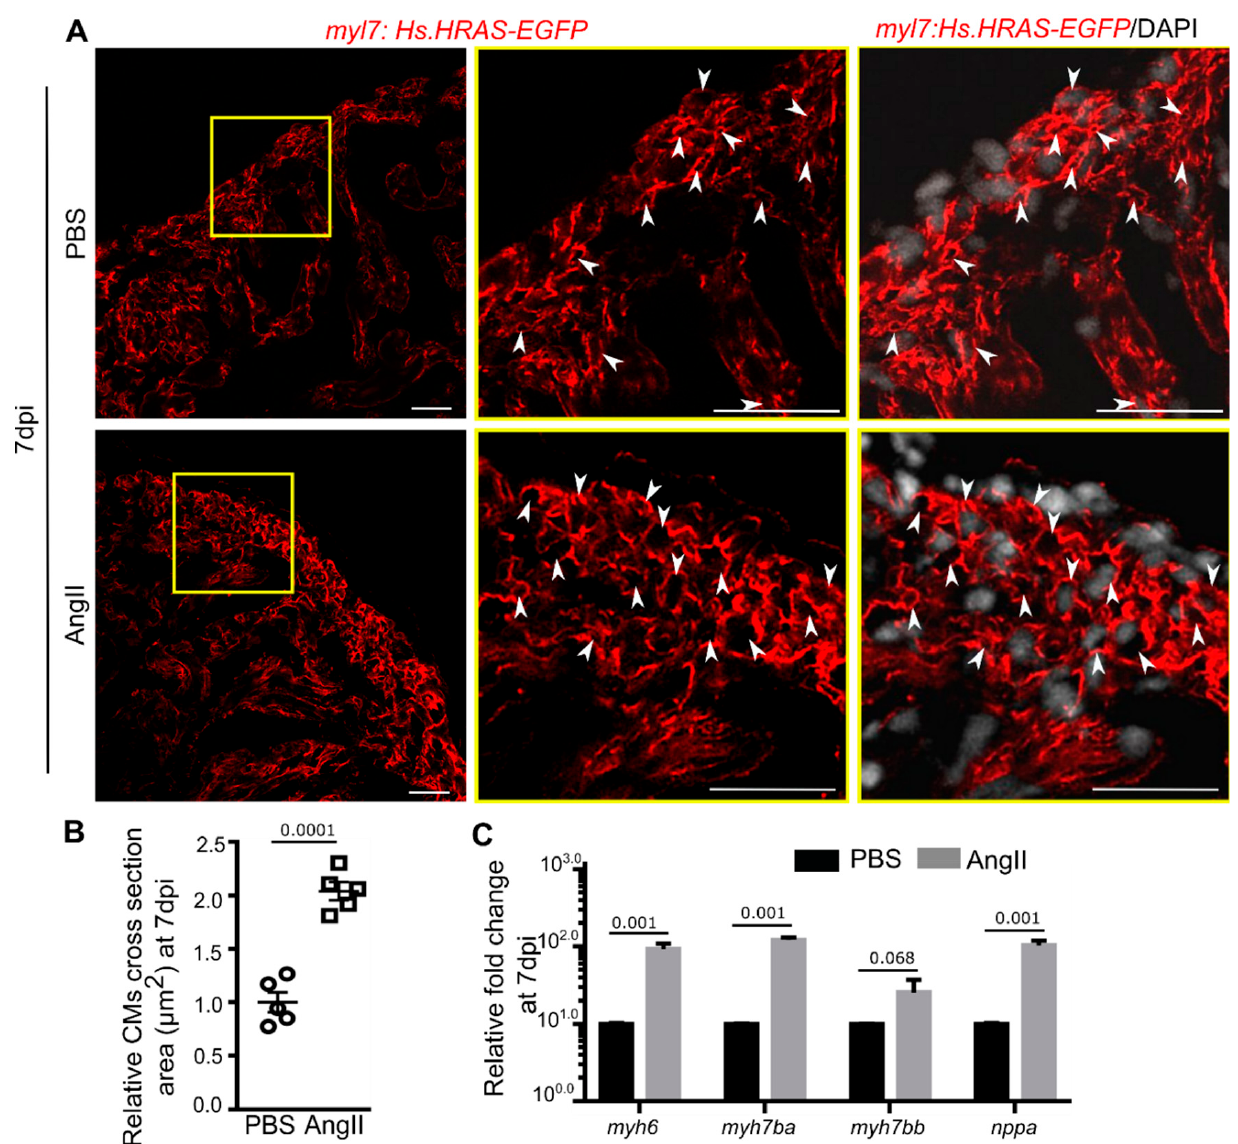
Figure 3. Angiotensin II induces cardiomyocyte hypertrophy in adult zebrafish. ( A ) Confocal optical sections of transverse cryosections of hearts isolated from PBS or AngII injected animals expressing EGFP in CM plasma membrane (red) and stained with DAPI (white; marks all nuclei). White arrowheads point to the plasma membrane of cross-sectioned CMs. ( B ) The dot plot represents the relative cross-sectional area of CMs at 7 dpi ( n = 5 each from two independent experiments). At least 50 CMs from each section and 2 sections from each heart were included in the analysis. The mean of the cross-sectional area of CMs from PBS injected hearts was set to 1. ( C ) Quantitative analysis of the expression of hypertrophy marker genes in cardiac ventricles from PBS or AngII injected animals at 7 dpi ( n = 3, each sample represents a pool of 6 hearts). Error bars indicate the mean ± s.e.m. values in C were normalized to the mean of PBS control. Dpi: days post-injection. Significant, p < 0.05; non-significant, p ≥ 0.05. Scale: 20 µm.